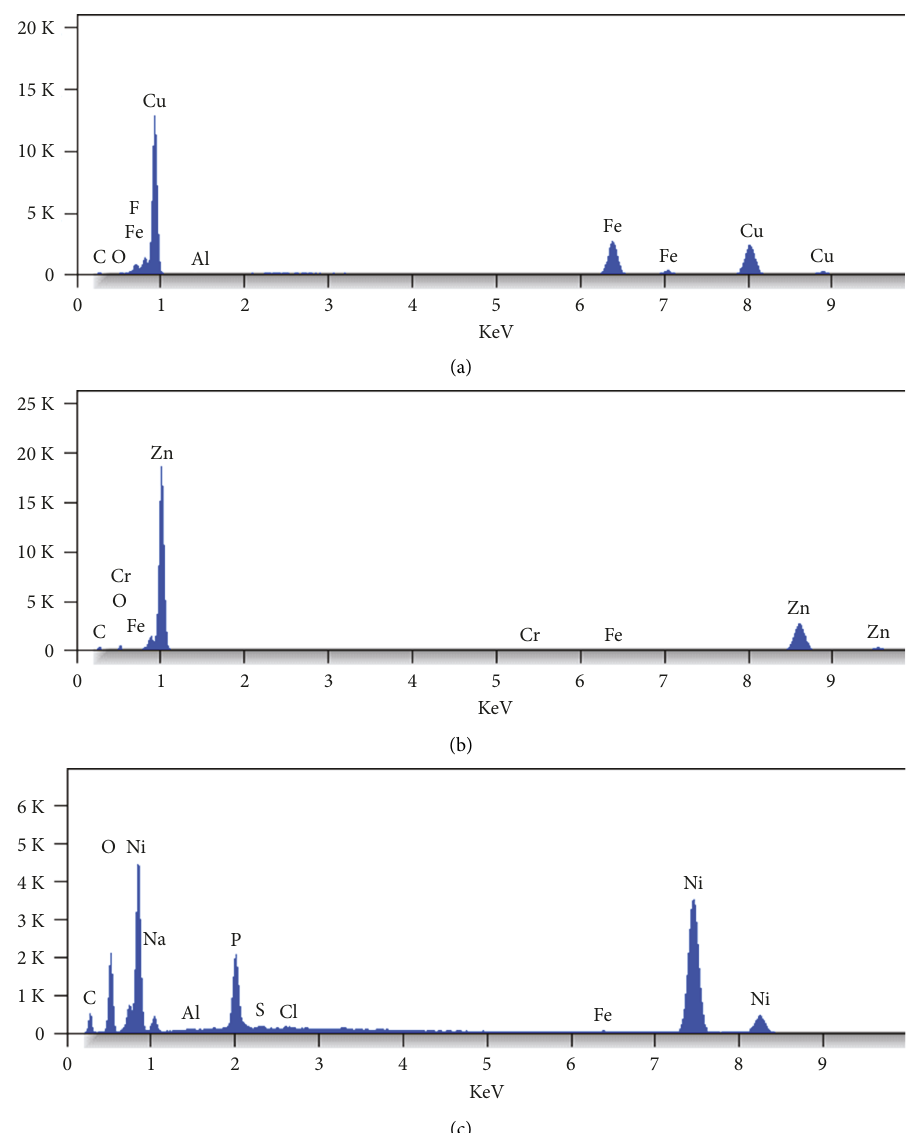
Figure 10: Energy dispersive spectroscopy (EDS) report of (a) Cu electroplated corten steel, (b) Zn electroplated corten steel, and (c) Ni electroplated corten steel.